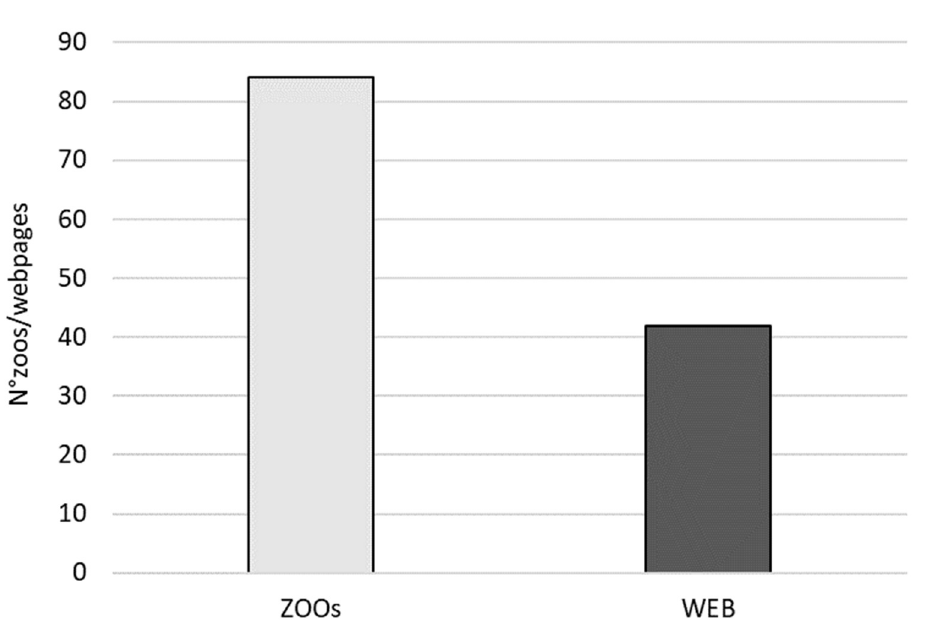
Figure 2. For each project (from A–N), the bar plot shows the number of zoos involved (Involvement) and the number of dedicated zoo-webpages (Communication). 3.2. Goals and Achievements Figure 3 reports the number of times different actions characterizing lemur conservation projects were set as goals and the number of times they were effectively achieved. Most of the projects had the following goals: “support/educate the local communities” and “habitat conservation”. We found a strongly significant positive correlation between goals and achievements (Rho = 0.954; p = 0.007).